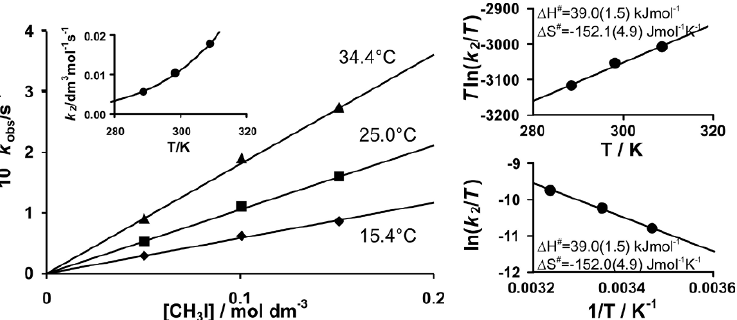
Figure 4. Temperature and iodomethane concentration dependence for observed pseudofirst-order rate constants k of iodomethane to [Rh(PhCOCHCOPh)(CO)(P(OCH according to Eq. 2. Right: Eyring plots according to Eqs. 3 and